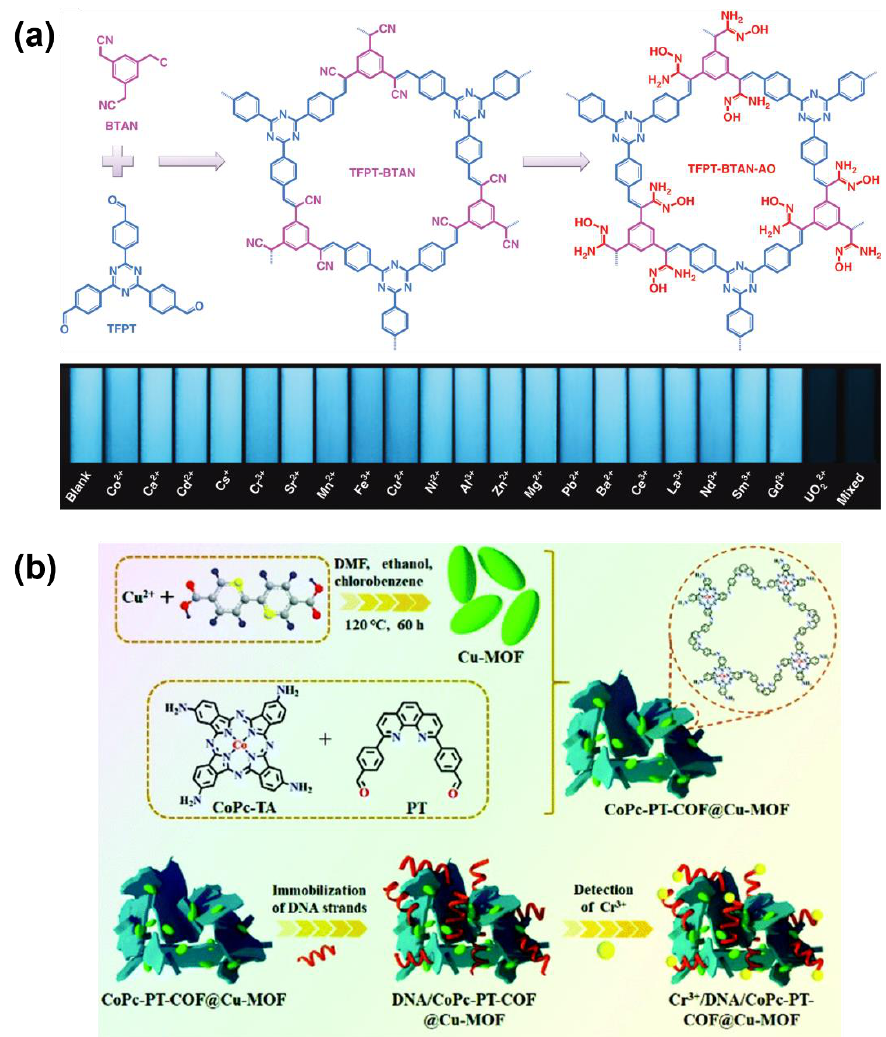
Figure 8. ( a ) TFPT − BTAN − AO for UO 22+ detection via fluorescence quenching [90]. Copyright 2020 Nature Publishing Group; ( b ) DNA/CoPc − PT − COF@Cu − MOF nanocomposite for Cr 3+ detec- tion [93]. Copyright 2021 Royal Society of